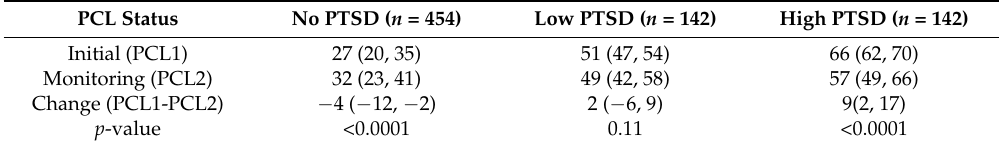
Table 3. Longitudinal assessment of PTSD score in severity